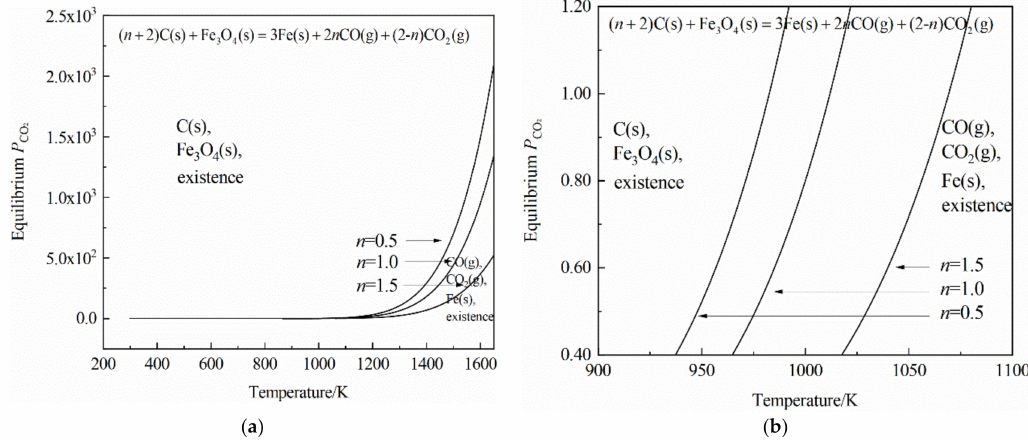
Figure 11. The equilibrium relative gas partial pressure of CO 2 as a function of temperature of the reaction of ( n + 2)C(s) +